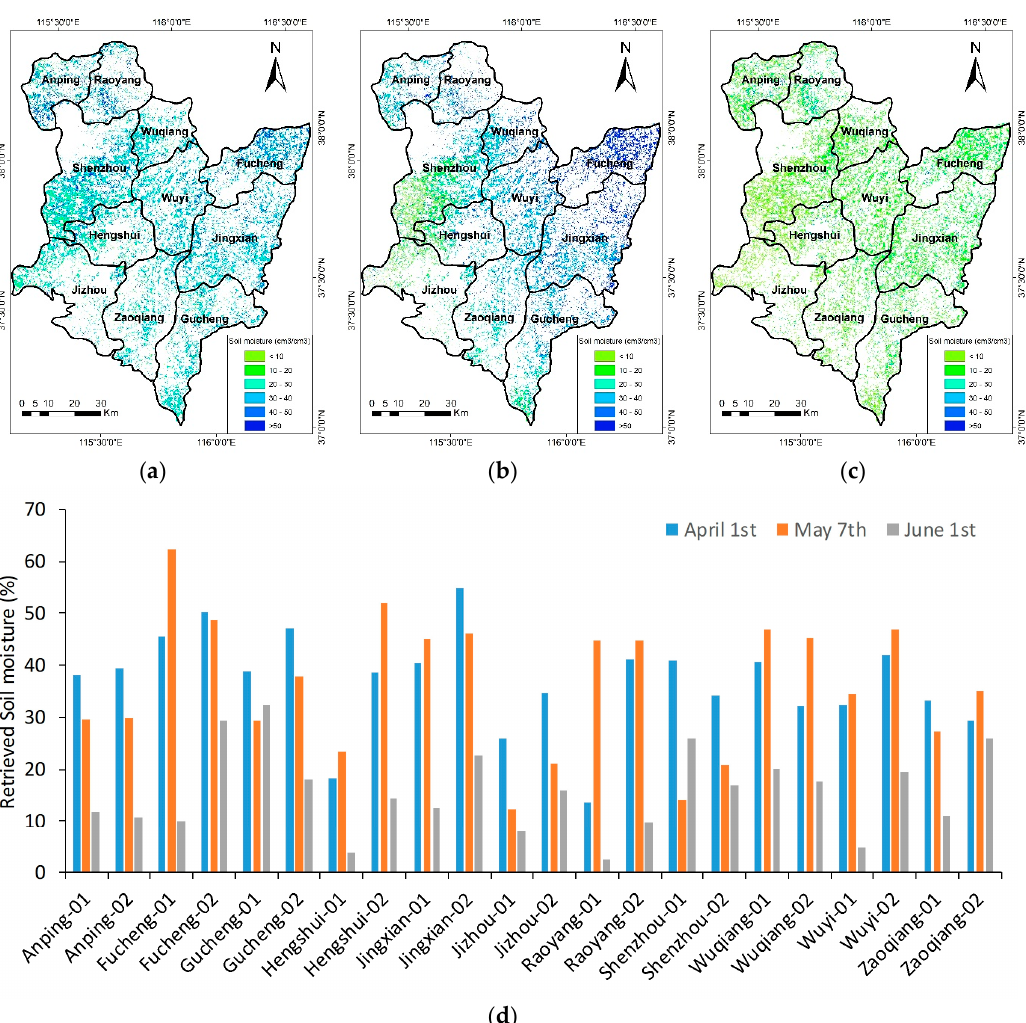
Figure 4. Maps of soil moisture in the study area retrieved from the water cloud model ( a ) 1 April, ( b ) 7 May and ( c ) 1 Jun. ( d ) Retrieved soil moisture content of 22 measured sites in Hengshui city over 3 time periods. (Every county has 2 measured sites).